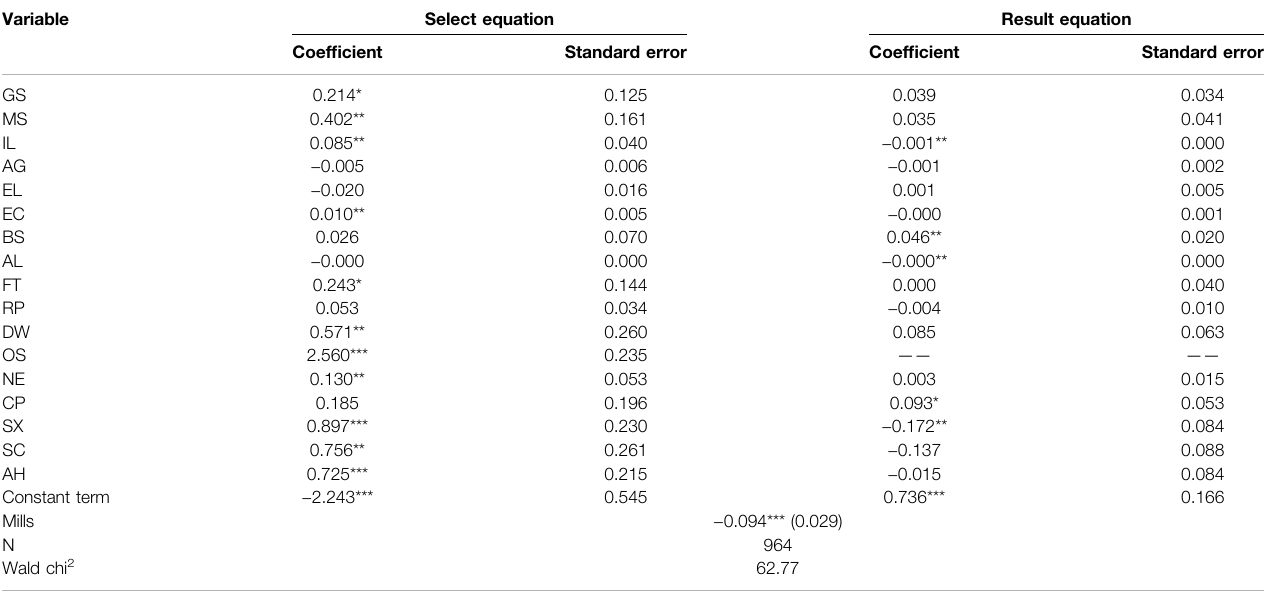
TABLE 2 | Benchmark regression results.